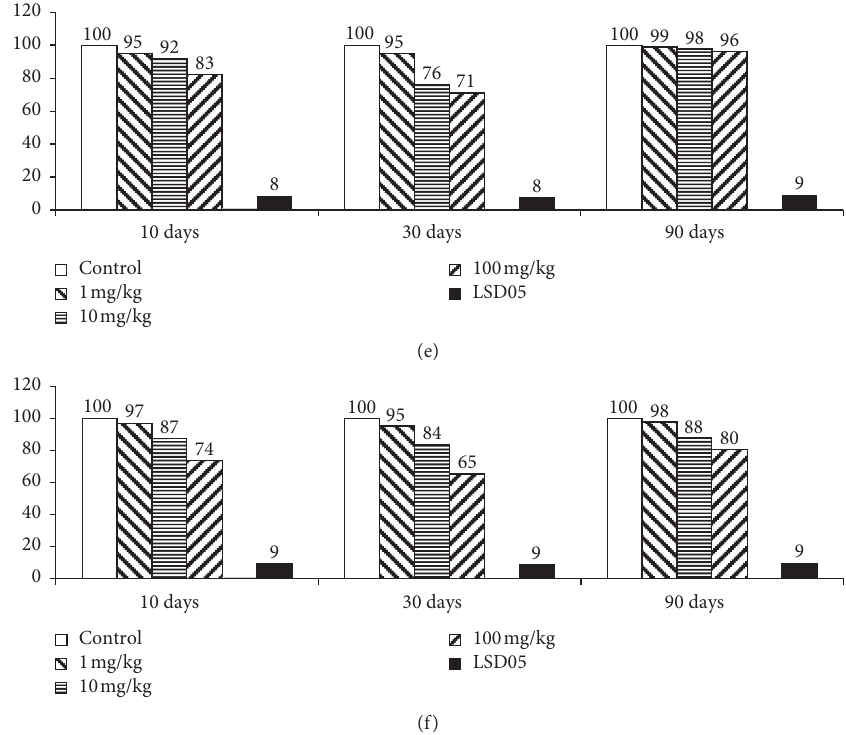
Figure 1: Changes in the biological state of chernozem 10, 30, and 90days after silver contamination. (a) Catalase activity, (b) activity of dehydrogenases, (c) total number of bacteria, (d) the abundance of bacteria of the genus Azotobacter , (e) length of the radish roots, %, and (f) integral indicator of the biological state of soils